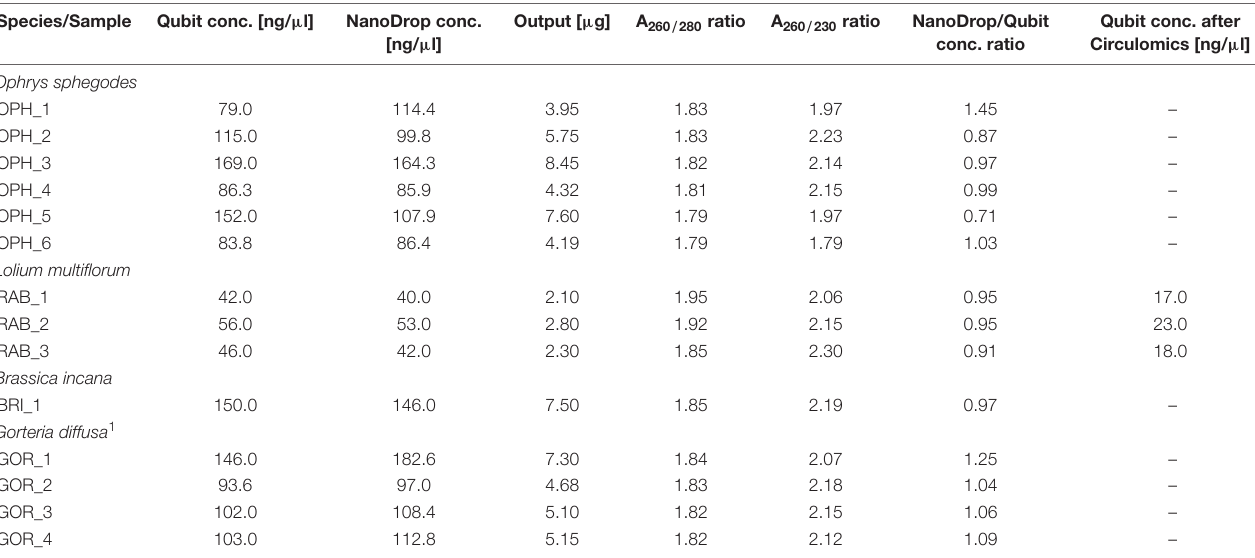
FIGURE 2 | Comparison of DNA extraction performance for different extraction methods. (A–C) Output from a NanoDrop spectrophotometer. (A) DNA extraction results with the Mayjonade et al. (2016) protocol, without β -ME and phenol:chloroform purification step. (B) DNA extraction with lysis buffer as described by Schalamun et al. (2019). (C) DNA extracted with the protocol described in this study (sample OPH_3). (D) TapeStation results showing the fragment size distribution and the DNA Integrity Number (DIN), for six O. sphegodes samples. TABLE 1 | Summary of DNA quality measurements for all extracted